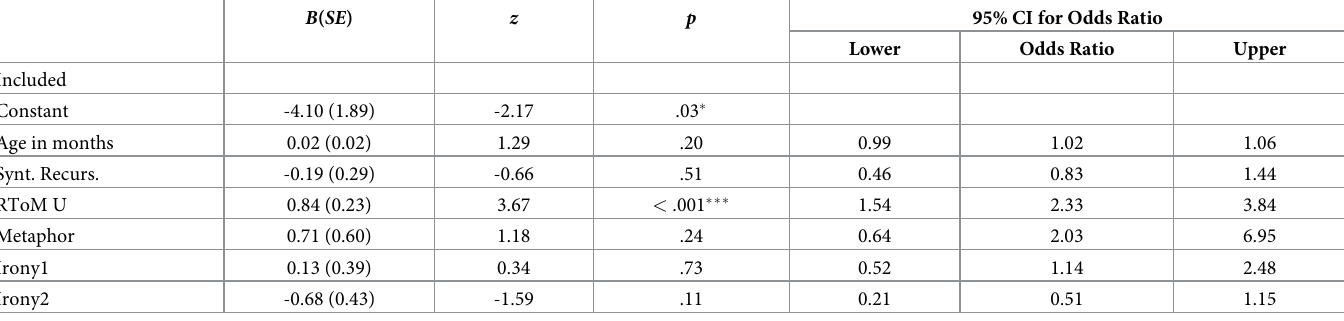
Table 4. Results of the logistic regression model predicting children’s TB performance with their age in months and their performance in tasks of syntactic recur- sion (Synt. Recurs.), Recursive ToM understanding (RToM U), and Advanced Pragmatics (Metaphor and Irony1 and Irony2 for irony test questions 1 and 2).